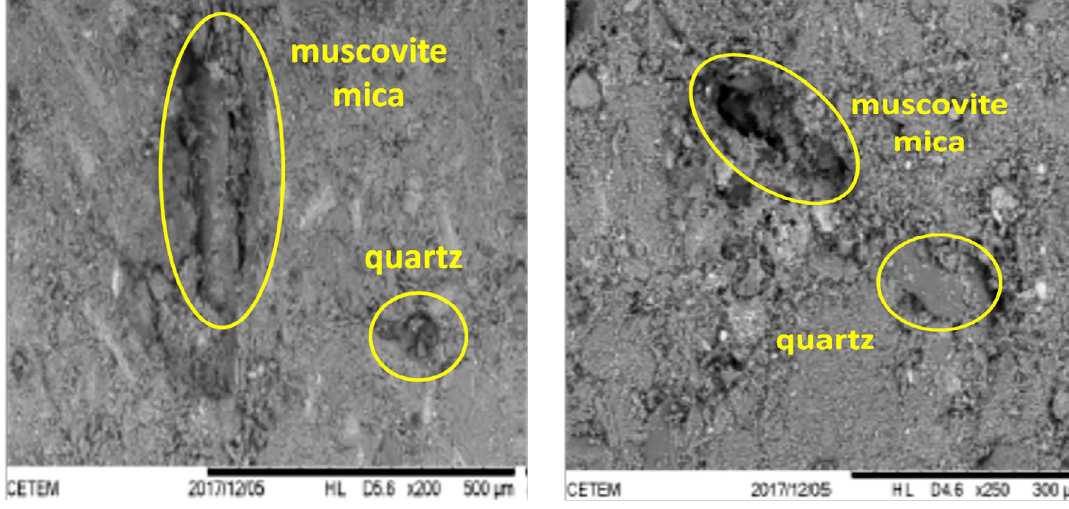
Figure 11. SEM fractography of the plain clay ceramic. Figure 12. SEM fractography of the 10 wt% Sulfatreat waste incorporated clay ceramic. Table 3. Results of leaching and solubilization tests. Concentration Leaching